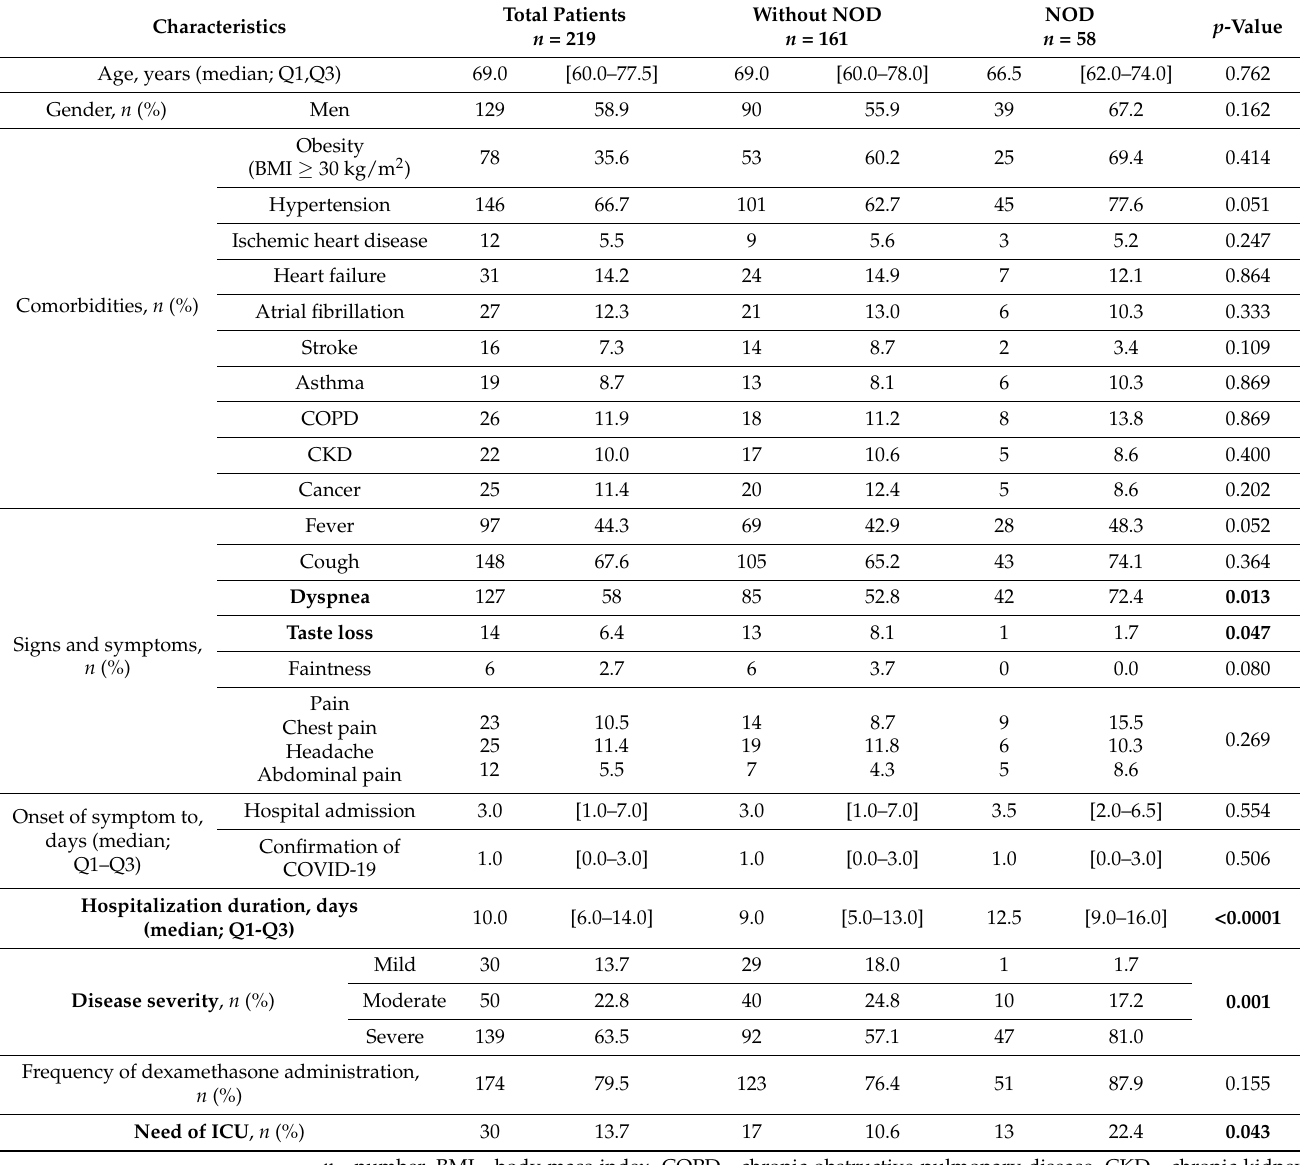
Table 1. Demographic and clinically relevant data of population.